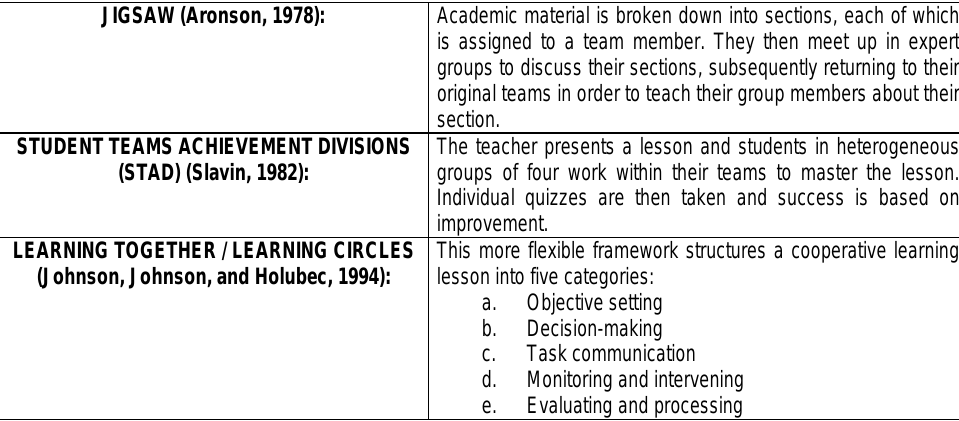
Table 12: Cooperativce learning